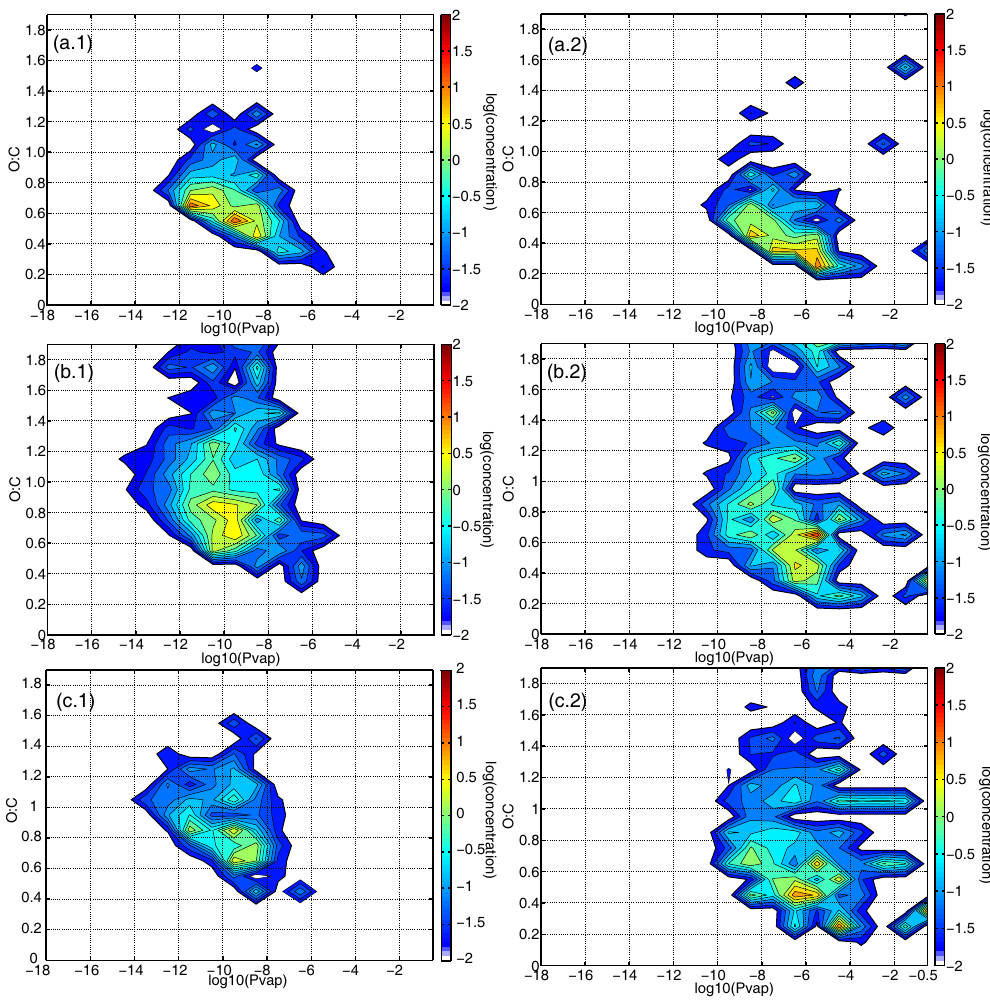
Fig. 10. Simulated distribution of gaseous and condensed secondary organics concentrations in µgm − 3 as a function of P vap (atm) and O:C ratio at the end of the (a) low, (b) intermediate and (c) high-NO x experiments, for the (1) particle, and (2) gas